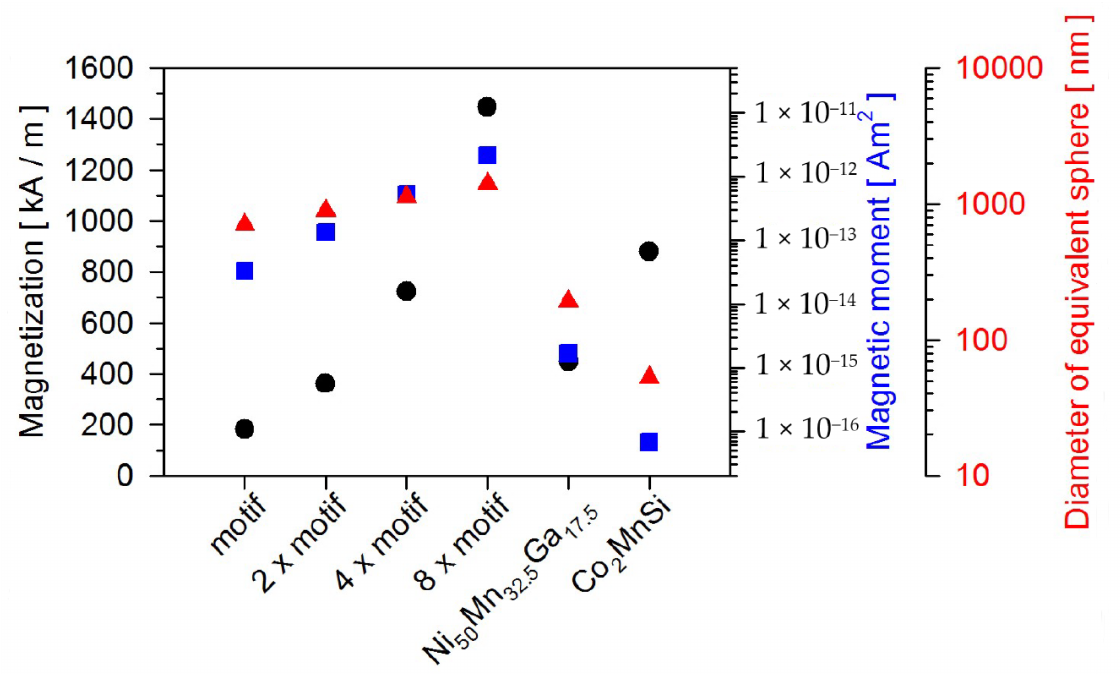
Figure 8. Resulting magnetization in black and magnetic moment in blue determined from the structural data of the particles produced by the top-down approach. Comparing the evolution of the magnetization of the particles when repeating the motif presented in Section 3.1 indicates their gain in magnetization as a function of the repetition. To be able to estimate the stray field interaction of these particles with a magnetoresistive sensor, the diameter of spheres with the equivalent volume of these particles is calculated and shown in